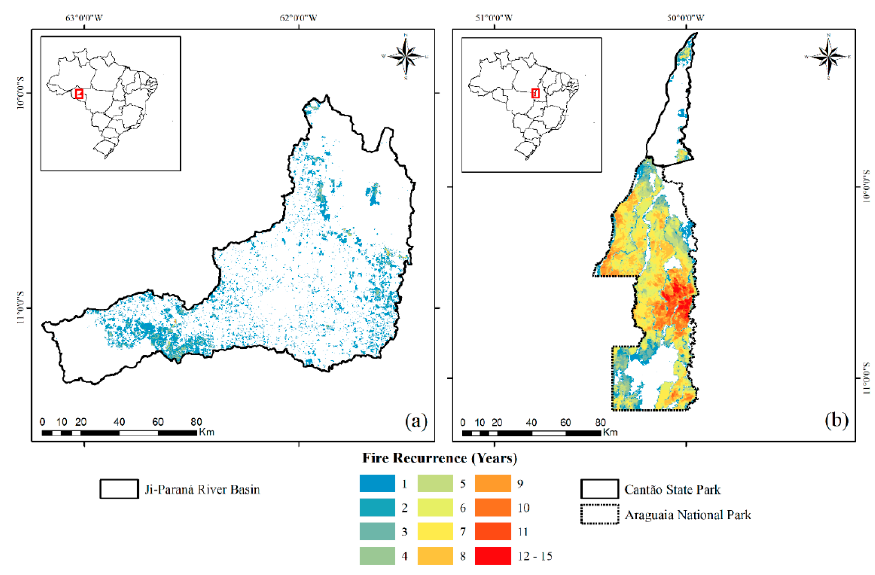
Figure 6. Fire Recurrence during the period 2001–2016 for: ( a ) Ji-Paraná River Basin, and ( b ) Araguaia National Park and Cantão State Park. Table 3. Area burned in square kilometer (km 2 ) by fire recurrence class in the period 2001–2016. Study